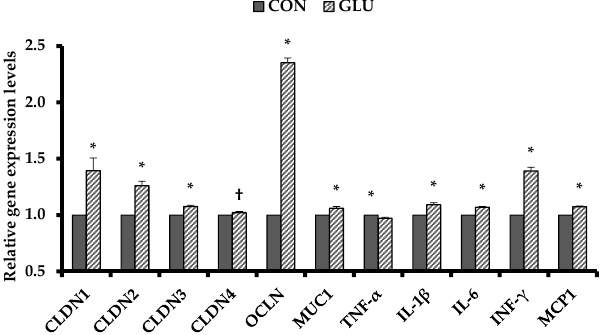
Figure 1. Relative ileal gene expression levels of tight junction proteins and inflammatory cytokines of weaned pigs. Each value is the main value of 6 replicates (1 pig/pen). CON = a typical weaner